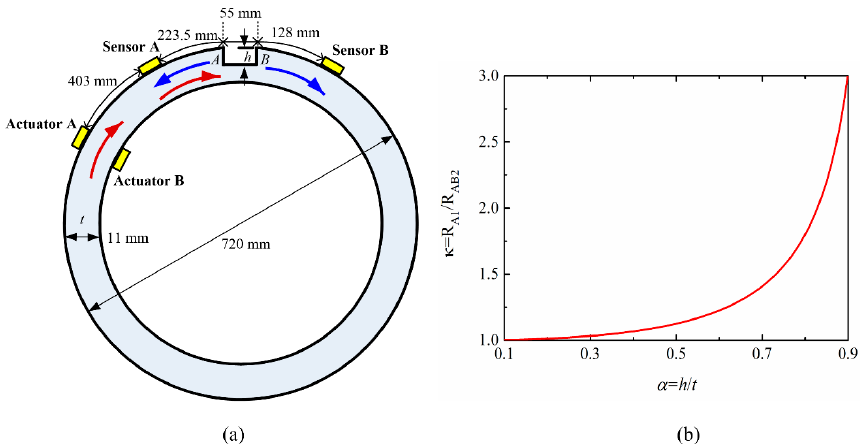
Figure 10. ( a ) Schematic of the experimental setup for monitoring the corrosion-like defect. ( b ) Theoretically predicted the change of the amplitude ratio κ of the two reflected signals versus the relative depth α of the notch defect.